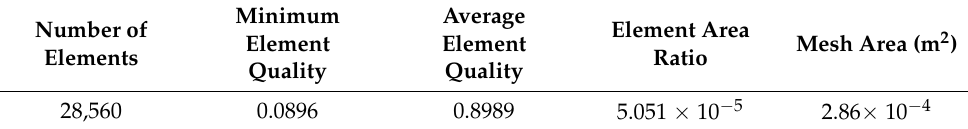
Figure 2. Triangular meshing using ComsolMultiphysics5.4. Table 2. Nodes and statistics of meshed domain.